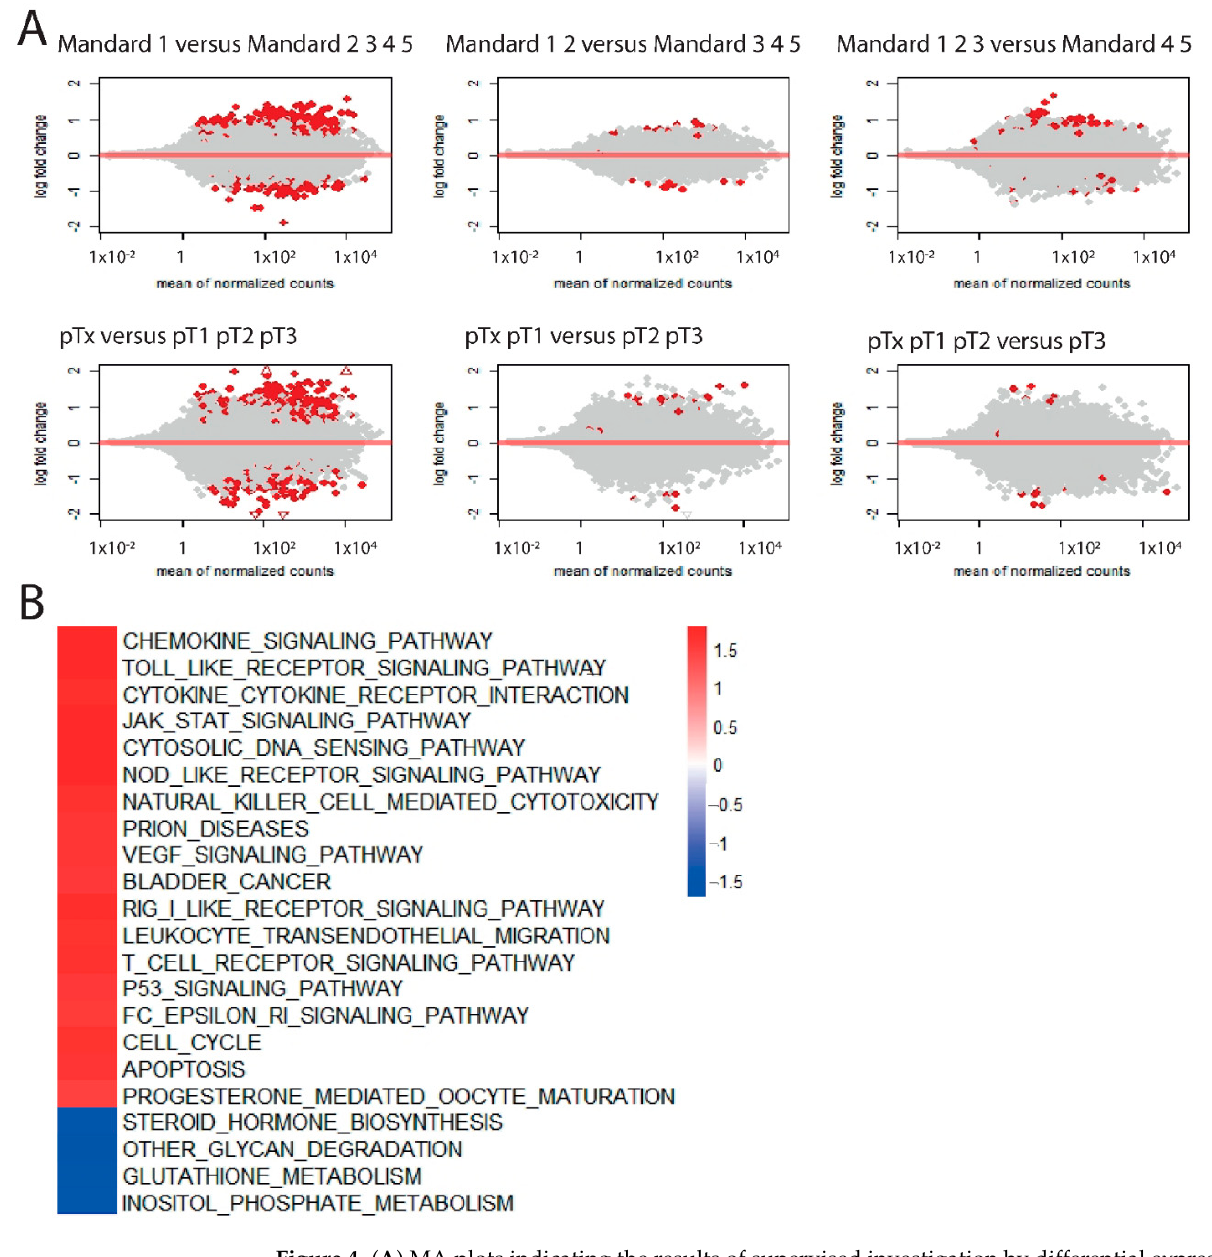
Figure 4. ( A ) MA plots indicating the results of supervised investigation by differential expression analyses in 65 patients treated with nCT/nCRT from the AUMC discovery cohort. Differentially expressed genes in red between patients with Mandard 1 versus higher Mandard scores (left upper plot) and pTx versus higher pT stadia (left lower plot). ( B ) Heatmap indicating GSEA results for patients treated with nCT/nCRT from the AUMC cohort. In red, enriched KEGG pathways in patients with Mandard 1, and in blue, enriched KEGG pathways in patients with higher Mandard